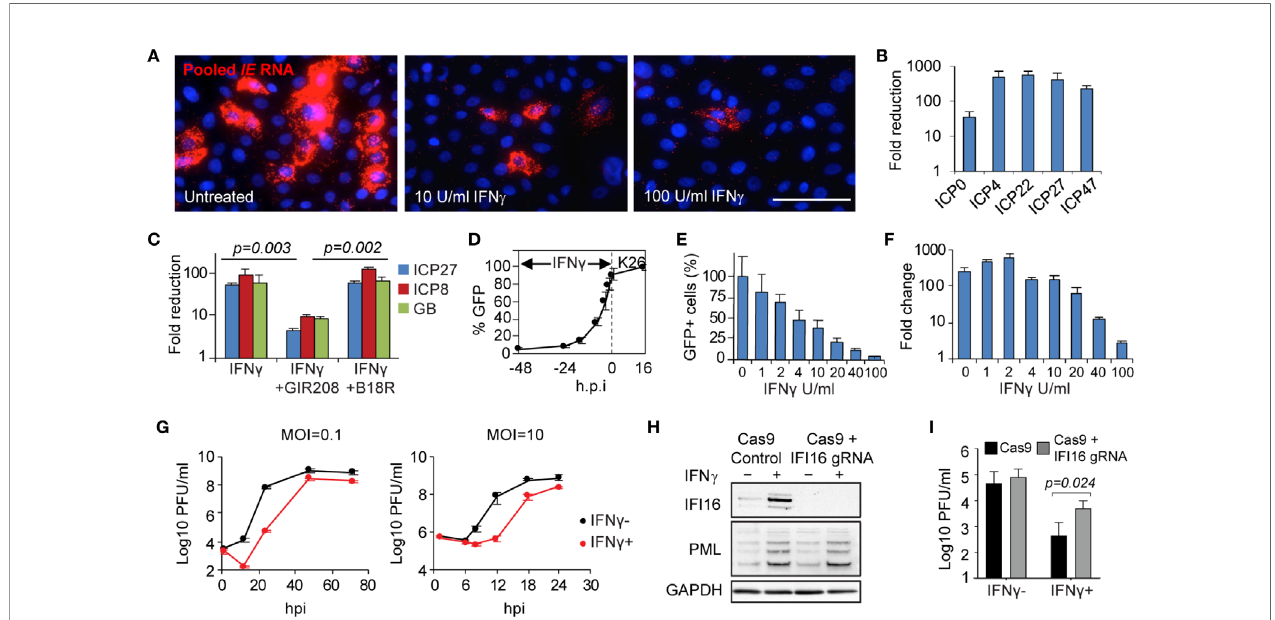
FIGURE 7 | Mechanism, speci fi city and effectiveness of IFN- g -mediated antiviral action in primary human skin cells. (A) Evaluation of IFN- g effect on HSV immediate early (IE) gene transcription via RNA FISH. In situ detection and visualization of IE gene expression using pooled probes speci fi c to each of the fi ve IE genes. Primary human keratinocytes 6 h.p.i. with K26 (MOI=1) either mock-treated or pretreated with IFN- g (10 U/ml or 100 U/ml). Scale bar, 50 µm. (B) Quantitative assessment of IFN- g -mediated reduction of IE gene expression via qRT-PCR. Primary human fi broblasts infected with wildtype strain KOS, MOI=1, 4 h.p.i. Mock treated compared to IFN- g treated, 100 U/ml. (C) IFN- g effect on HSV gene transcription (ICP27, ICP8, and glycoprotein B) in the presence or absence of interferon blockers, GIR208 and B18R. Primary human keratinocytes infected with KOS, MOI=1, 4 h.p.i. (D) Time-dependent inhibition by IFN- g . Percentage of GFP-expressing cells in K26-infected primary human keratinocytes 16 h.p.i. (MOI=1) with IFN- g treatment initiated at 2, 4, 8, 16, 24, or 48 hours prior to infection. (E, F) Dose-dependent inhibition by IFN- g . GFP expression (E) and viral DNA replication (F) under increasing dosage of IFN- g in K26-infected keratinocytes. MOI=1, 16 h.p.i. HSV genome DNA were quanti fi ed by qPCR and compared between 2 and 16 h.p.i. (G) Growth kinetics of strain KOS under low and high MOI in primary human fi broblasts with (100 U/ml) or without IFN- g . (H) Responsiveness to IFN- g in IFI16 knockout and Cas9 control human fi broblasts. Immunoblot of whole-cell lysate from IFI16 knockout and Cas9 control cells mock-treated or pretreated with IFN- g (500U/mL) for 20 hours. One of three biological replicates is shown. (I) Viral yield 12 h.p.i. following wildtype HSV-2 strain 186 infection (MOI=0.1) of IFI16 knockout and Cas9 control fi broblasts mock-treated or pretreated with IFN- g (500U/mL) for 20 hours. Two-way ANOVA with Holm-Sidak ’ s multiple comparisons test. Values are mean ± S.D. ( error bars ), from three independent